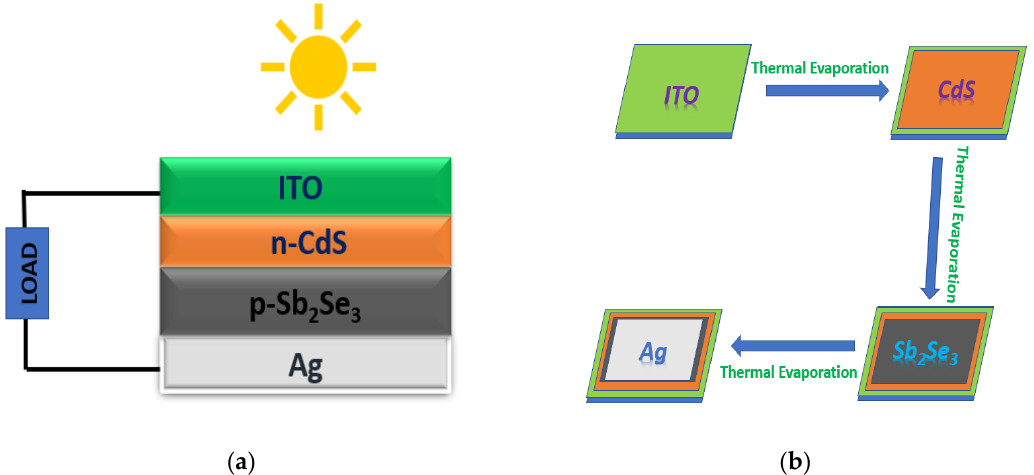
Figure 2. Schematic of ( a ) device structure and ( b ) deposition method.